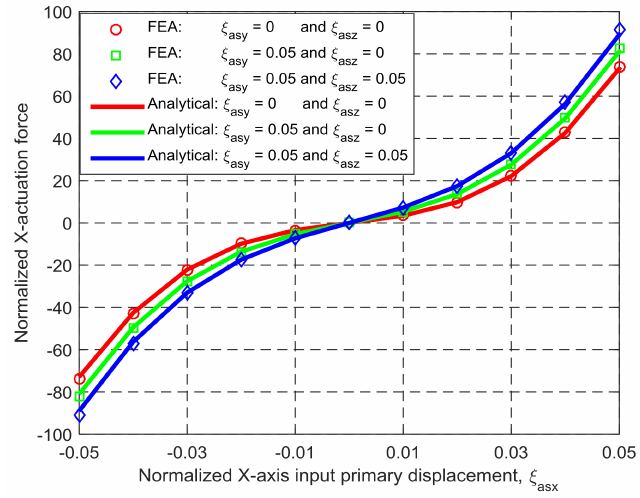
Figure 6. Comparison between the analytical results and the finite element analysis (FEA) results in terms of the force-displacement